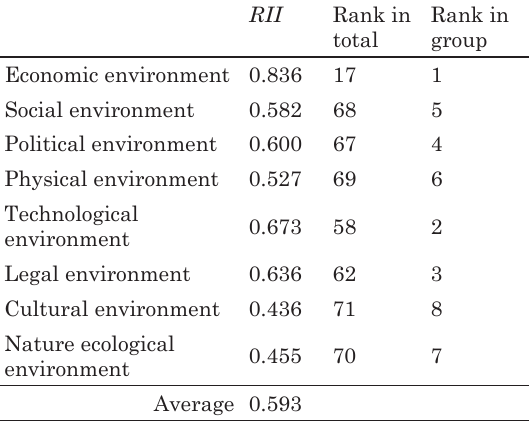
table 1. Summary of survey results on external